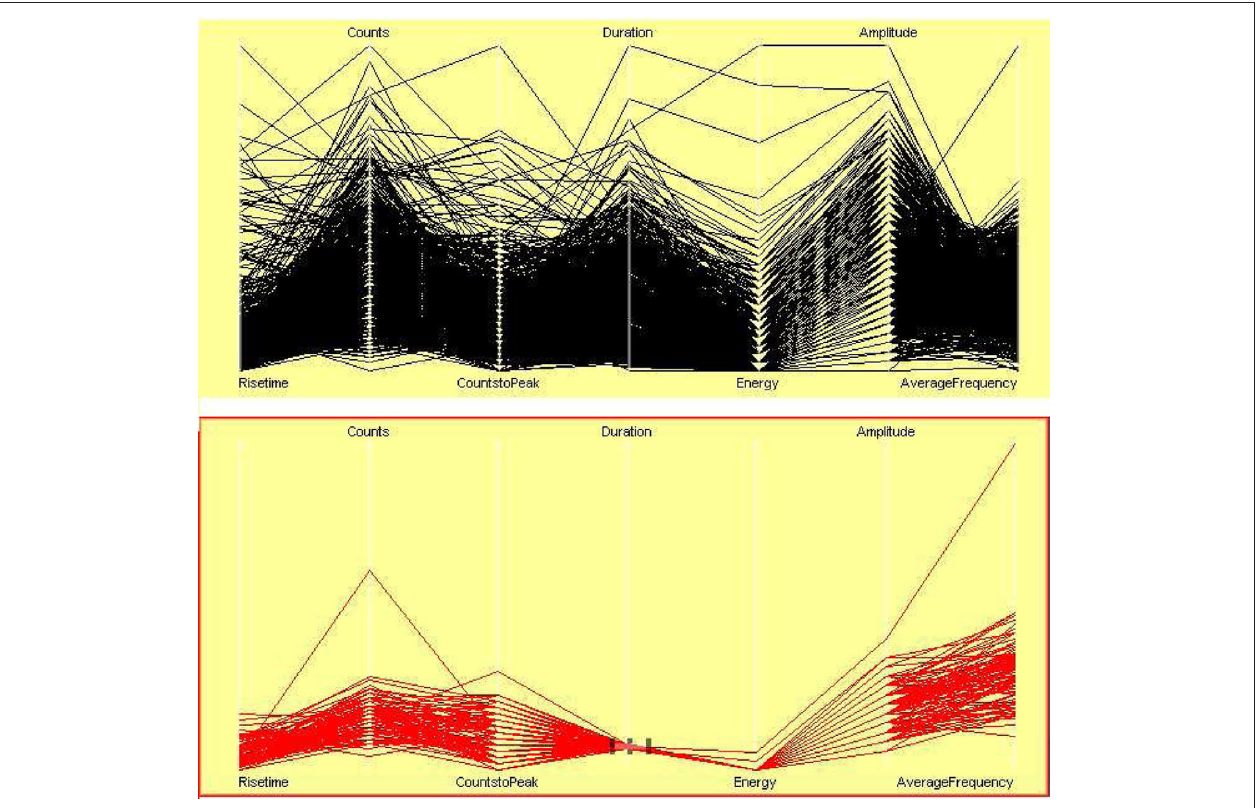
FIgurE 19 | Parallel coordinate plots of seven related variables. Signals of duration between 117 and 122 s are highlighted, and rest of the cases are filtered